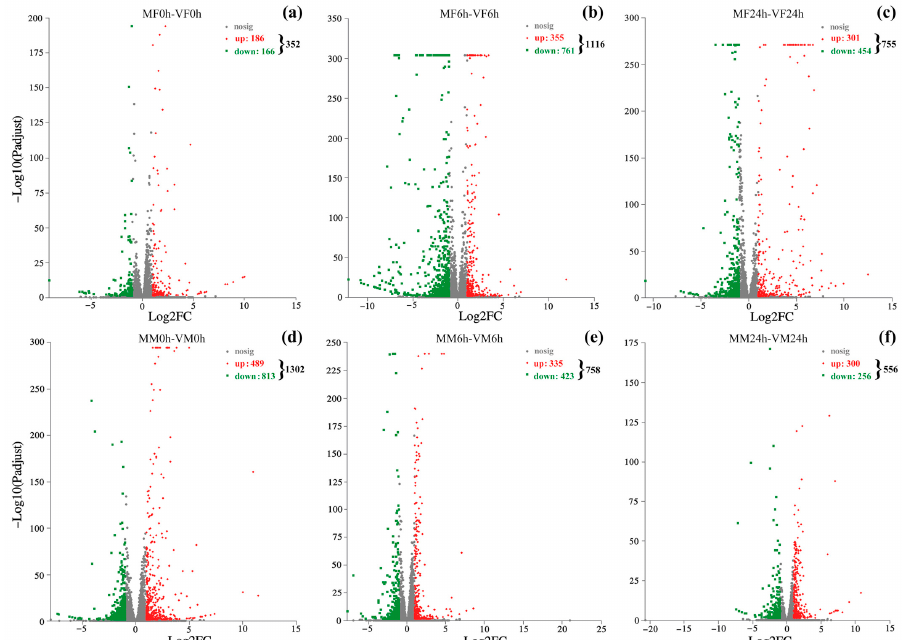
Figure 3. Volcano plots of DEGs in S. frugiperda . ( a – c ) are DEGs of mated vs. virgin females at 0, 6 and 24 h postmating, respectively; ( d – f ) are DEGs of mated vs. virgin males at 0, 6 and 24 h postmating, respectively. Genes with significantly differential expression are indicated by red dots (upregulated) and green dots (downregulated). Blue dots indicate genes with no significant differential expression.